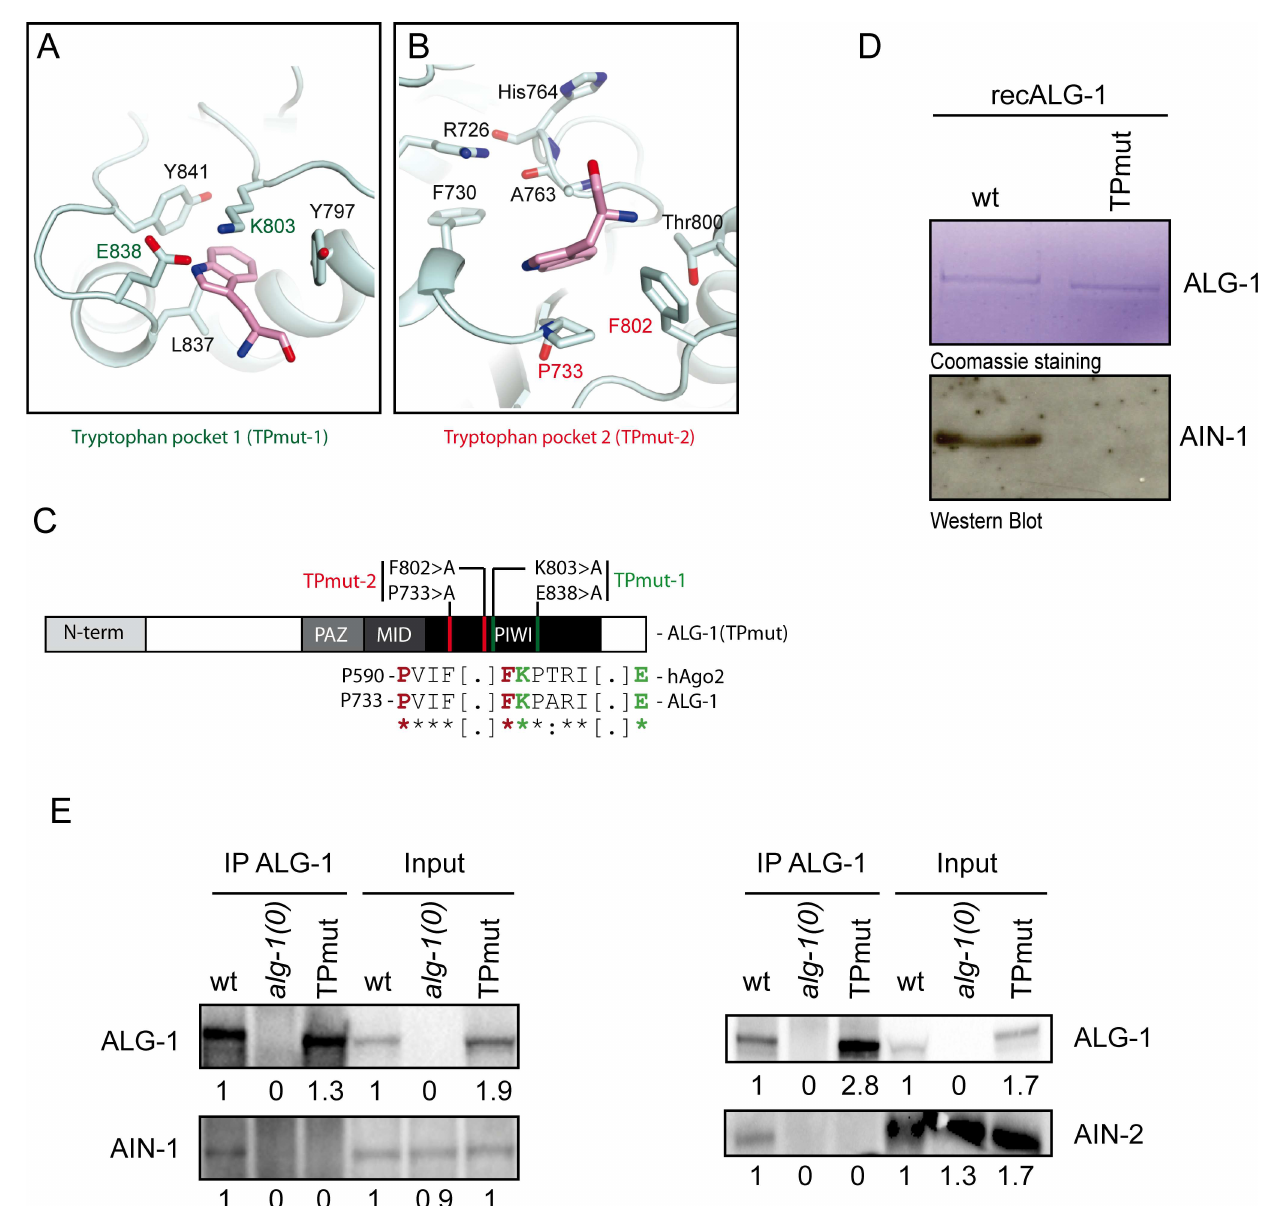
Fig 1. The Tryptophan-binding pockets of ALG-1 are essential to mediate the interaction with AIN-1 and AIN-2 proteins in vitro and in vivo . (A and B) Putative Tryptophan-binding pockets of ALG-1. A homology model (pale cyan) of ALG-1 tryptophan-bindingpockets 1 (A) and 2 (B) was generatedby Swiss-Model from 4OLB and superposed on the tryptophan (pink)-bound hAgo2 structure (PDB code: 4OLB). hAgo2 is not shownfor clarity. (C) Schematic view of ALG-1 structured protein domains. The residues forming the tryptophan-binding pocket 1 and 2 are colouredin green and red respectivelyand mutated into non-polaramino acid alanineto generate an ALG-1 Tryptophan- bindingPockets mutant (hereafter namedTPmut). (D) GST pull-down assaysusing bacterially expressedGST-Tagged wild-type or tryptophan-binding pocket mutants of ALG-1 protein. An AIN-1 peptidefragment containingthe AGO BindingDomain(350-641aa) was purifiedand co-immunoprecipitated with recombinantGST-tagged ALG-1 or ALG-1(TPmut) protein. The upper part of gel was stained with Coomassie Brilliant Blue and the lower blotted with antibodyagainst AIN-1. (E) Co-Immunoprecipitation of ALG-1 wild-type or mutant and AIN-1 and AIN-2 proteins from whole C . elegans extract. Transgenic animalswere generated using MosSCI singlecopy insertionof mCherry-tagged ALG-1 wild-typeor TP mutant (TPmut). Animalswere then crossed into alg-1(0) geneticbackground. ALG-1 proteinsfrom young adults animalswas co-immunoprecipitated using ALG-1 specific antibody and AIN-1 and AIN-2 proteins were detected by Western Blotting. Inputs represent the equivalentof 20% and 25% of the total protein extracts used for the IPs for detecting AIN-1 and AIN-2, respectively.Numbers indicate the relative level of proteinsin input and Co-IP comparedto wt for each strain.